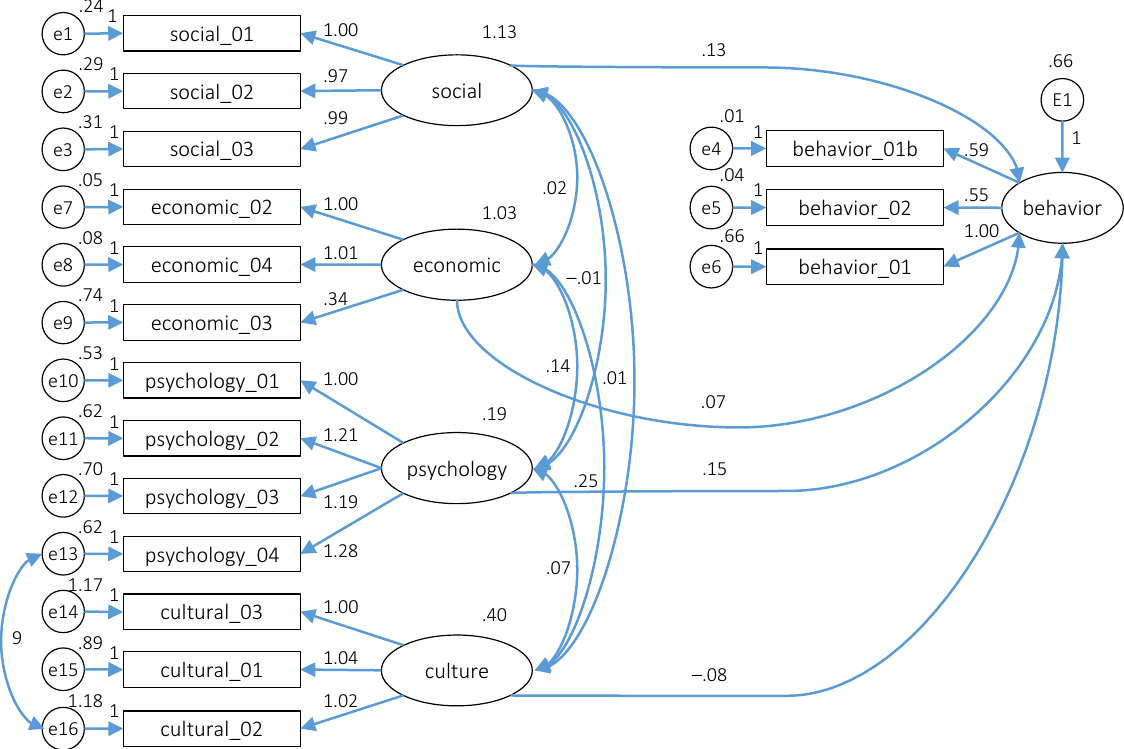
Figure 2. Structural model